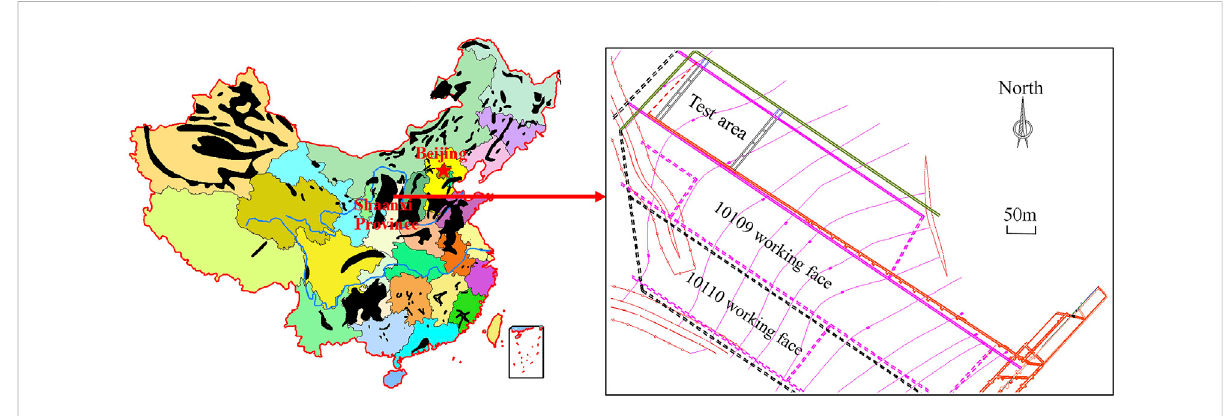
FIGURE 1 Details of the test area used in this study.